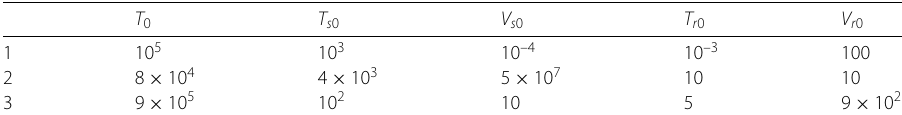
Table 5 Initial values of model (2)